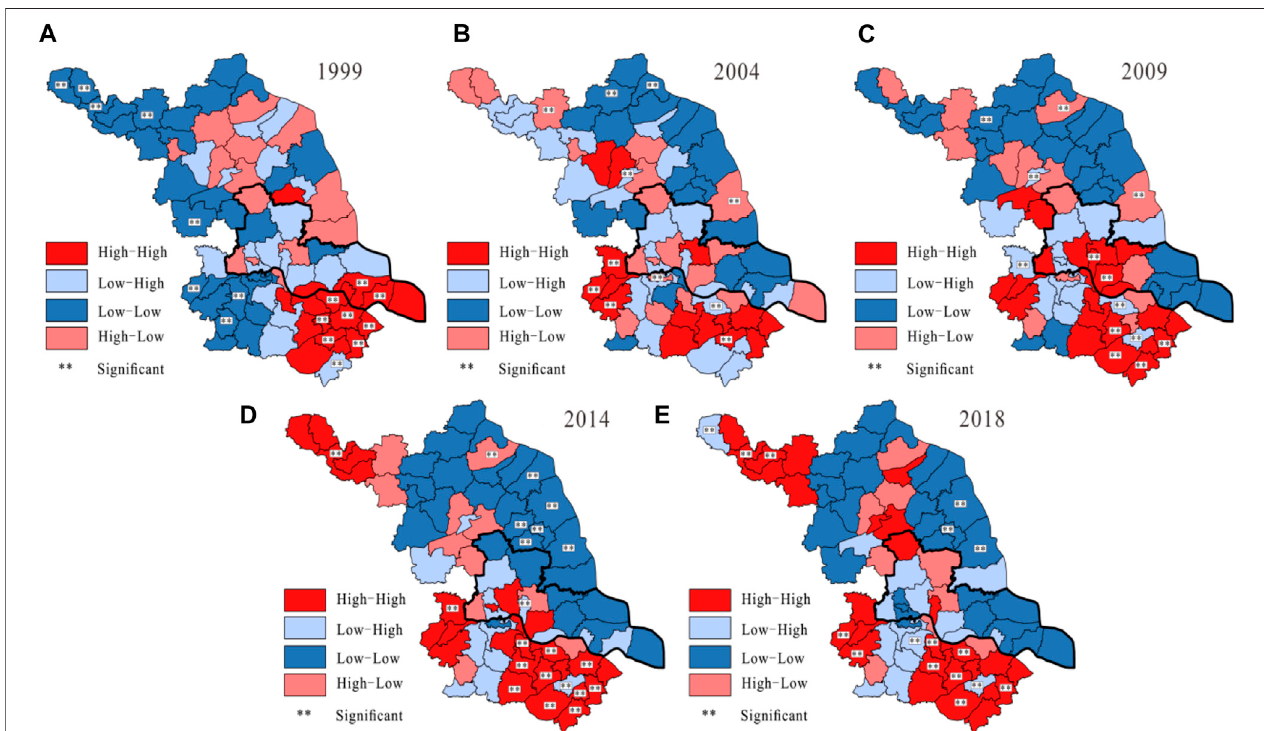
FIGURE 5 | Spatial association pattern of regional agricultural eco-ef fi